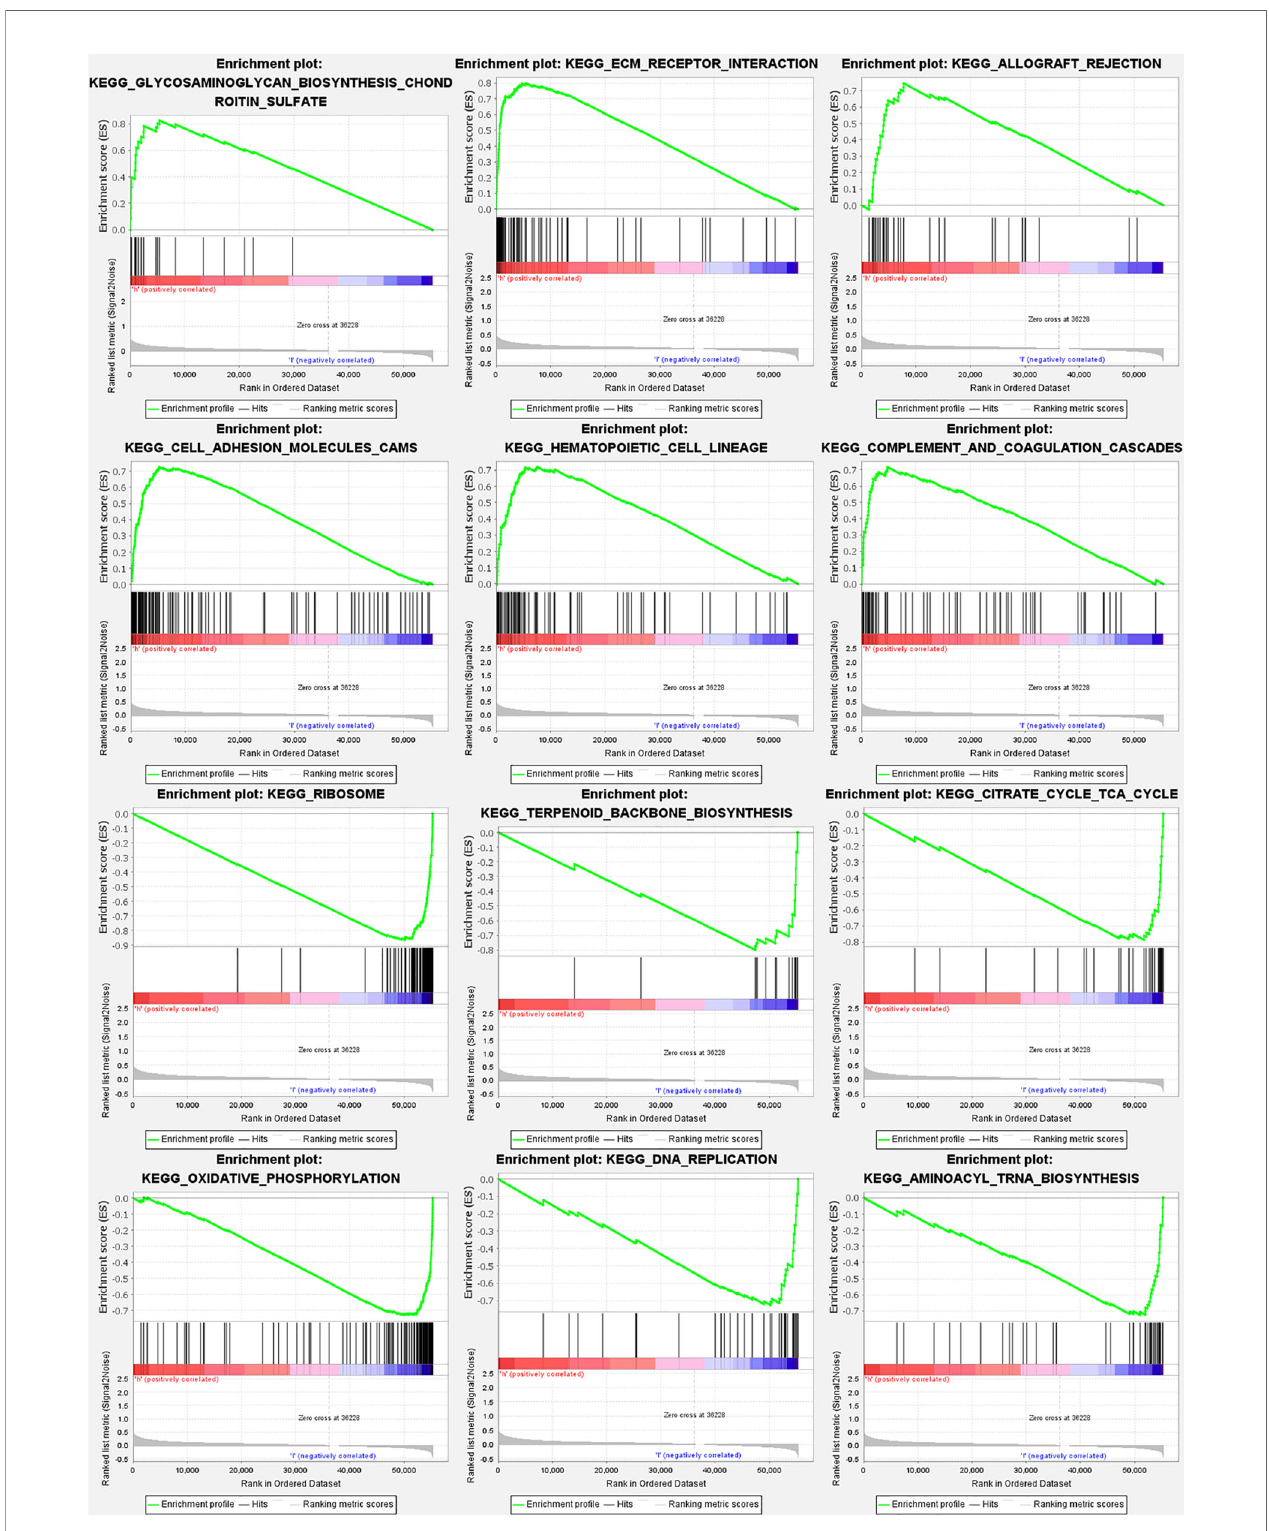
FIGURE 9 | Gene set enrichment analyses for genes participating in autophagy. To clarify the difference of related function or pathway in different samples, the top 6 enriched functions or pathways of each cluster were listed. The most enriched pathway was the Hedgehog signaling pathway. Both FDR q-value and FWER P value were